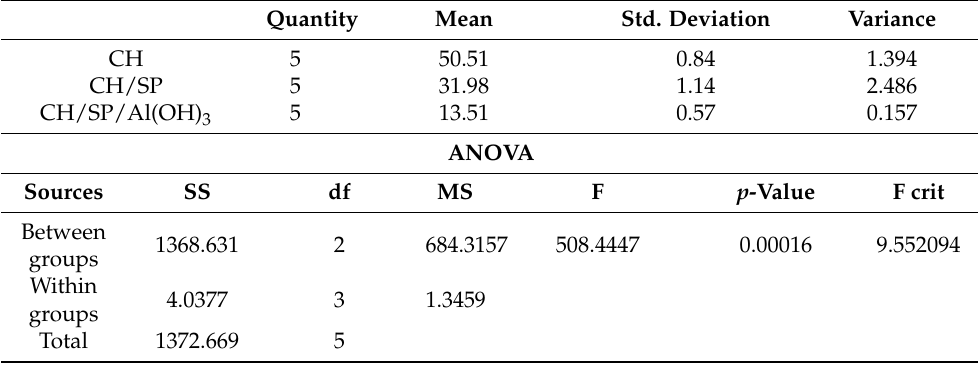
Figure 5. LOI ( a ) and flame burning tendency ( b ) of the original wood, CH wood, CH/SP wood, and CH/SP/Al(OH) 3 wood samples. Table 1. Correlation data of self-extinguishing time and one-way ANOVA.